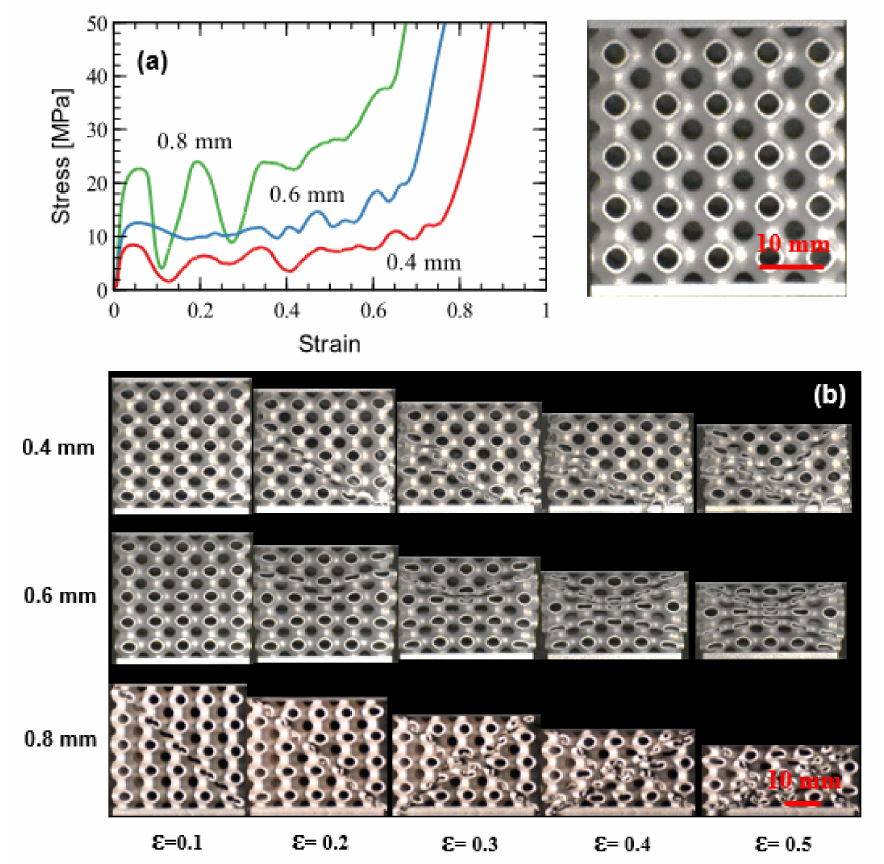
Figure 12. ( a ) Stress–strain curves for Schwarz-P TPMS structure under compression with 0.4, 0.6 and 0.8 mm wall thicknesses, and ( b ) Schwarz-P TPMS deformation sequence for each of the three wall thickness specimens at increasing